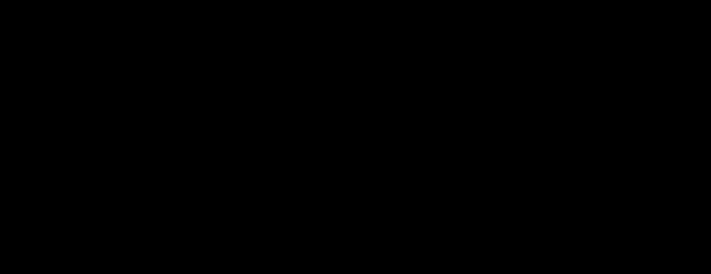
The different phenotypes in the parents. (A) The female parent “Jihua 5” with scale bar of 10 cm. (B) The male parent “M130” with scale bar of 10 cm.